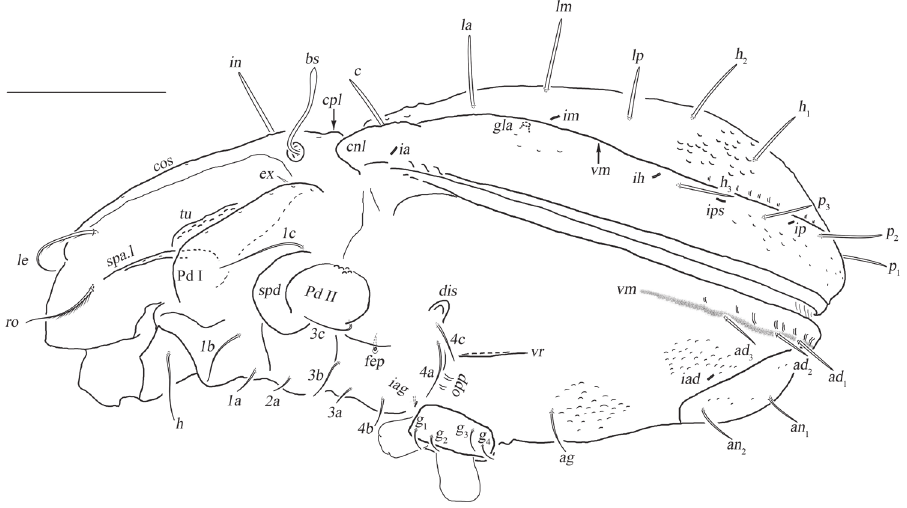
Figure 3. Basiceramerus ovatus sp. nov. adult: lateral view (legs not illustrated). Abbreviations and nota- tions explained in text. Scale bar: 200